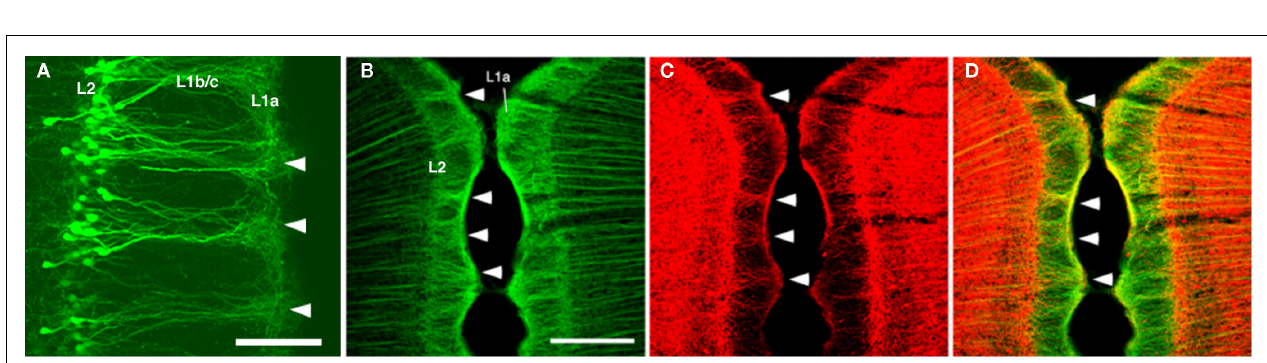
FIGURE 2 | (A) Dendritic bundles in layer 1 [postnatal day (P) 10], visualized by electroporation of enhanced green fluorescence protein (EGFP) at embryonic day (E) 18. (B–D) Confocal micrographs of layer 1 of the rat GRS stained by